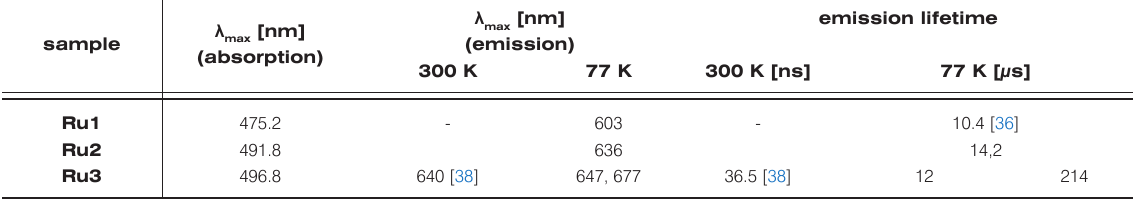
Table 1. Comparison of selected spectroscopic parameters for Ru1, Ru2 and Ru3. At room temperature no emission could be detected for Ru1 and Ru2 [36].